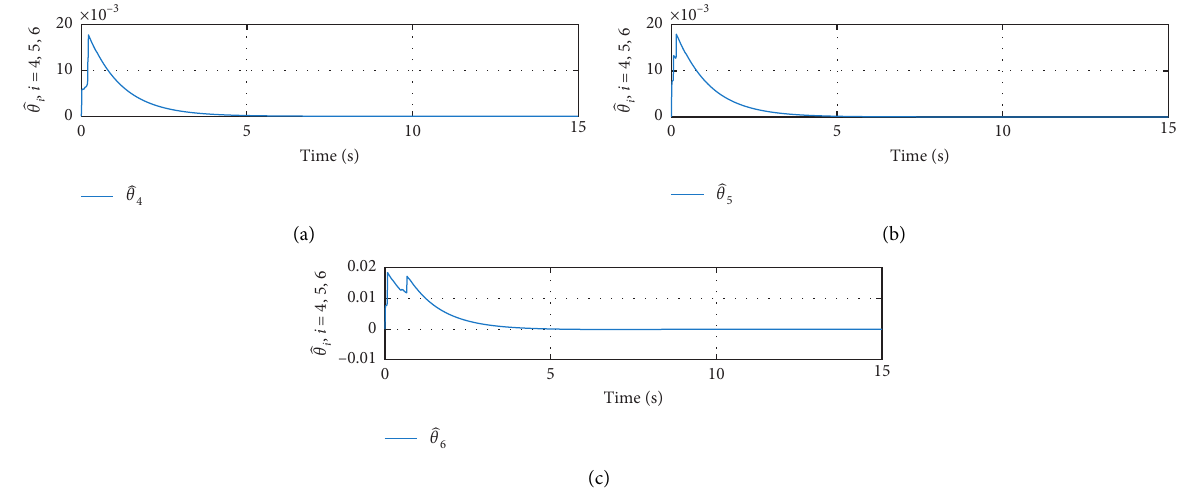
Figure 6: Response curves of 􏽢 θ